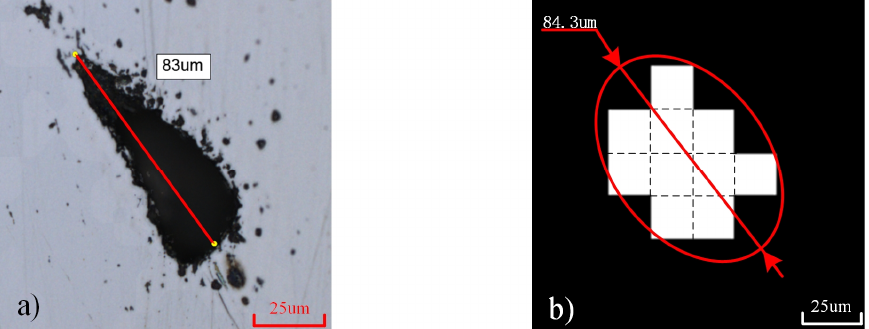
Figure 11. Images of the same inclusions detected by different methods. ( a ) inclusion morphology by laser scanning confocal microscopy (LSCM); ( b ) inclusion image by ultrasonic microscopy after morphological filtering. Table 3. Proportion of inclusions area by different methods.